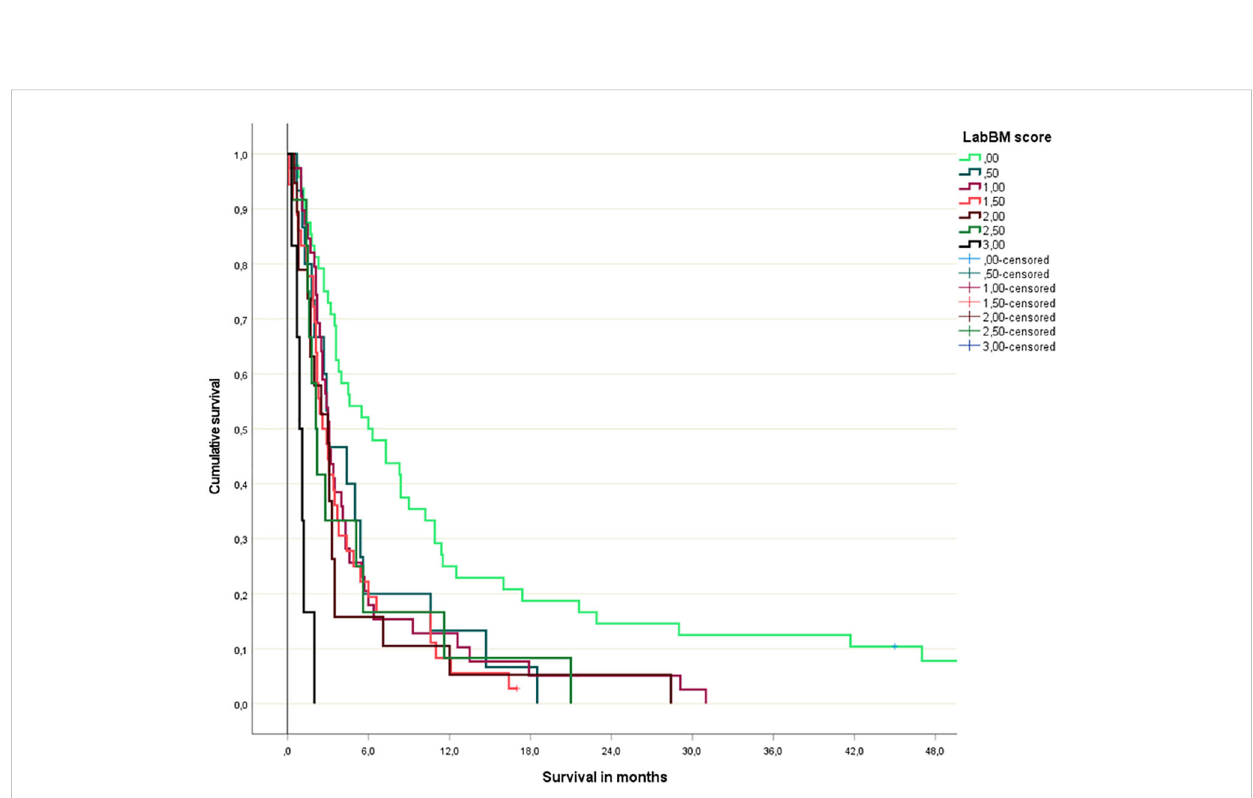
FIGURE 6 Original LabBM score (Kaplan-Meier analysis; p=0.04 or better for all comparisons involving patients with 0 points; p=0.003 or better for all comparisons involving patients with 3